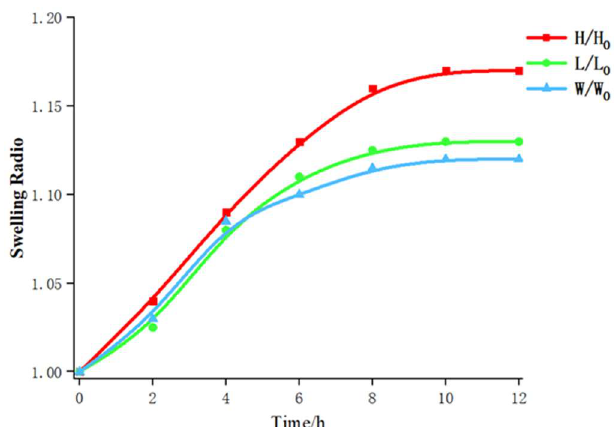
Figure 11. The swelling properties of the SF-PNIPAM dual-crosslinked nanocomposite film .